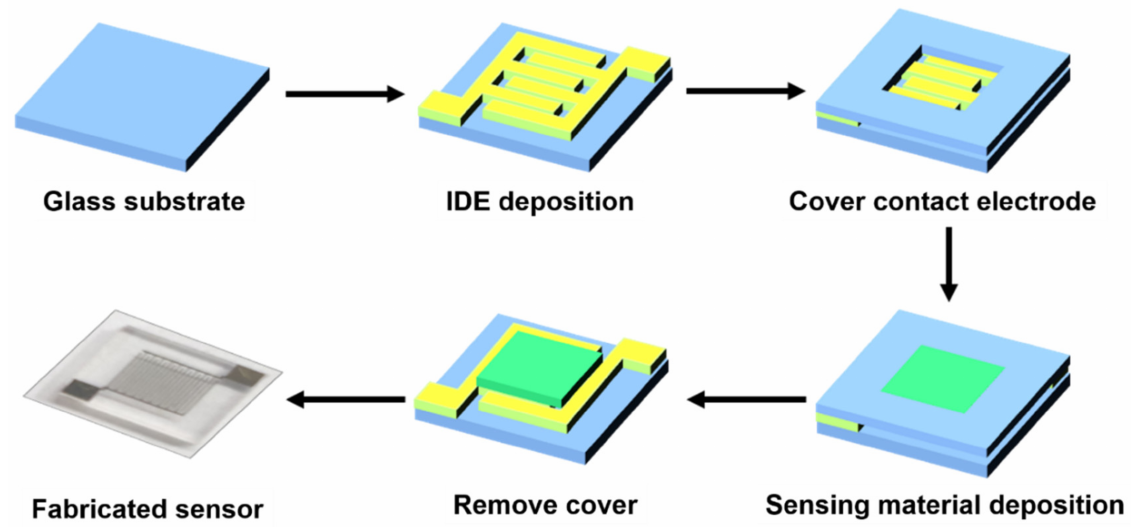
Figure 1. Schematic for SnO 2 gas sensor fabrication.